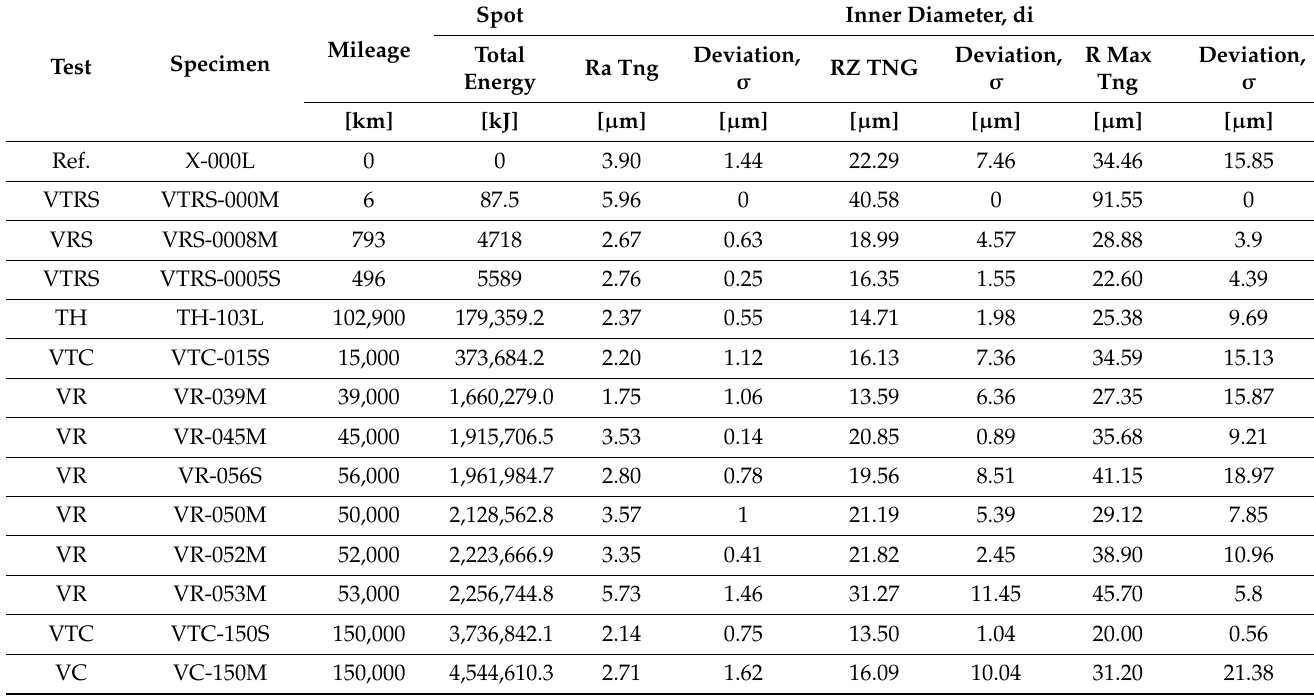
Table A3. Summary of the surface roughness values before (reference) and after different tests: inner diameter, tangential direction.